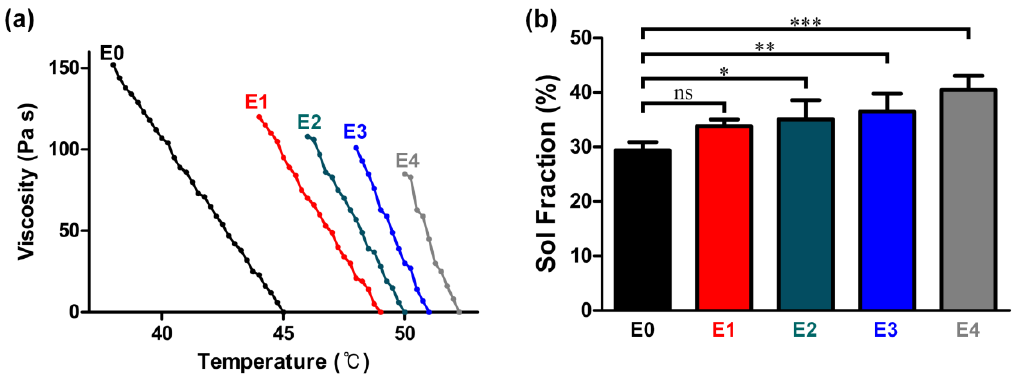
Figure 1. ( a ) Viscosities of ESM/GG hydrogel solutions including different concentrations of ESMs at different temperatures. ( b ) Sol fractions of ESM/GG hydrogels containing different concentrations of ESMs. Error bars mean the standard deviation (n = 4). One-way ANOVA with Dunnett’s multiple comparison test was carried out to compare the sol fractions of ESM/GG hydrogels containing different concentrations of ESMs. In Graph Pad Prism 6 software, a significant difference is indicated as follows: NS (not significant) p > 0.05, * p < 0.05, ** p < 0.01, and *** p < 0.001.